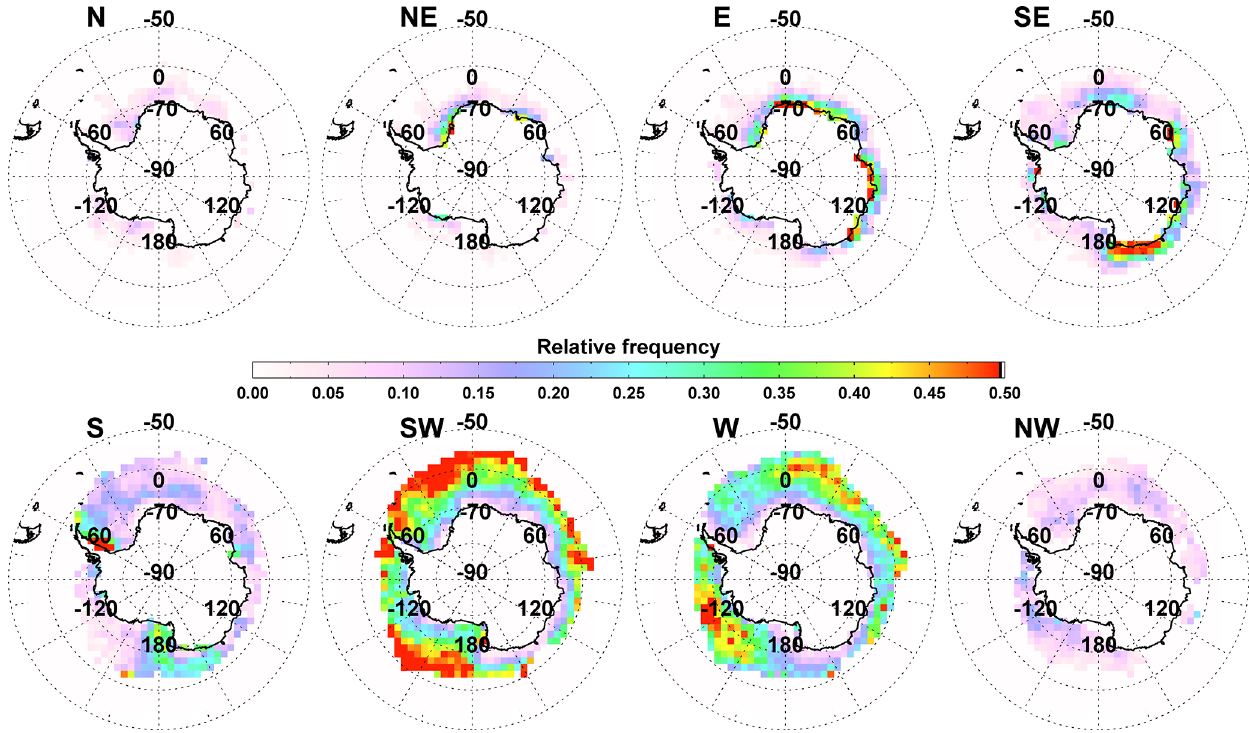
Figure 15. As Fig. 13 but for the Antarctic during spring (September to October in